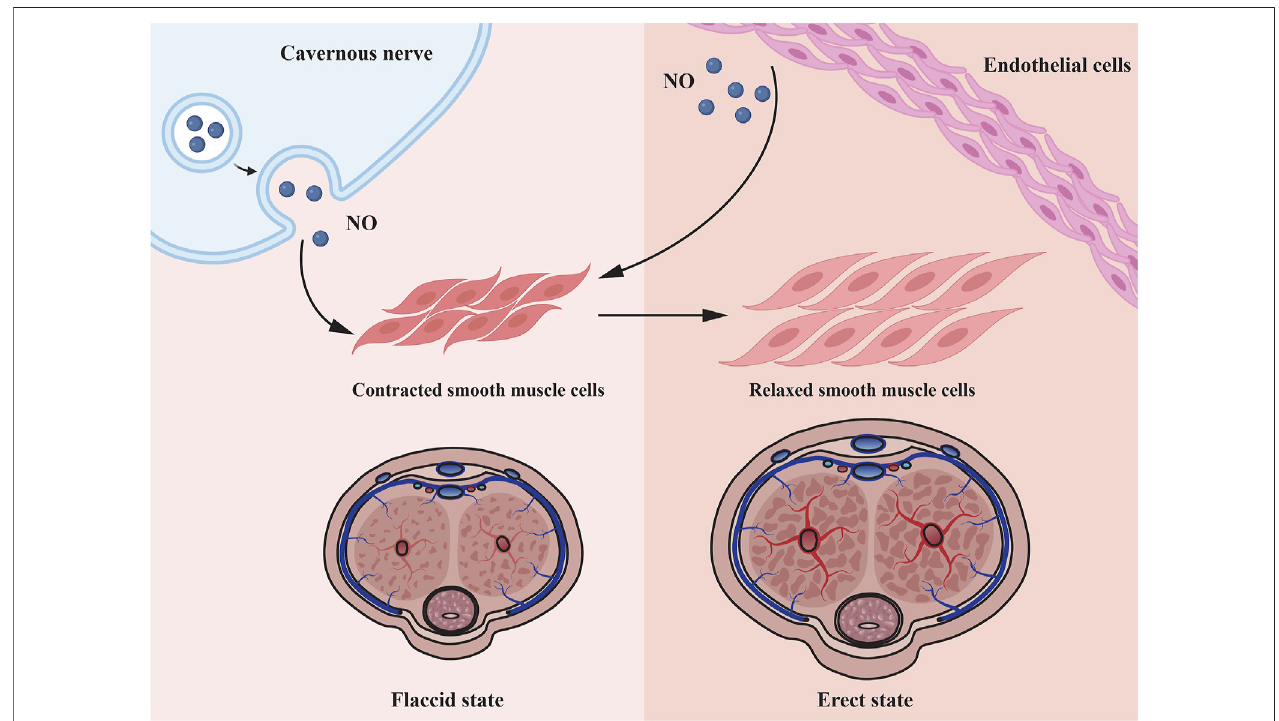
FIGURE 1 | Microscopic mechanisms underlying penile smooth muscle relaxation. Cavernous nerve and endothelial cell all can secrete NO to relax corpus cavernosum smooth muscle cells. As the smooth muscle relaxes, blood fi lls the lacunar spaces, resulting to compression of the subtunical venules, thereby restricting the venous out fl